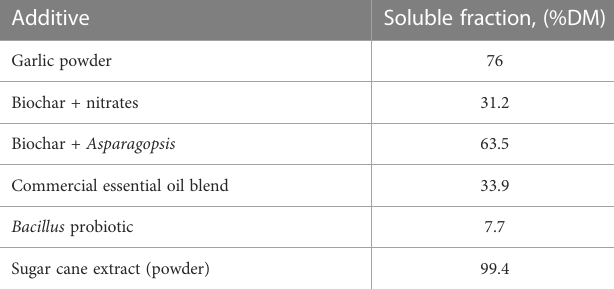
TABLE 2 Soluble fraction of powder additives evaluated in in vitro batch culture incubation.